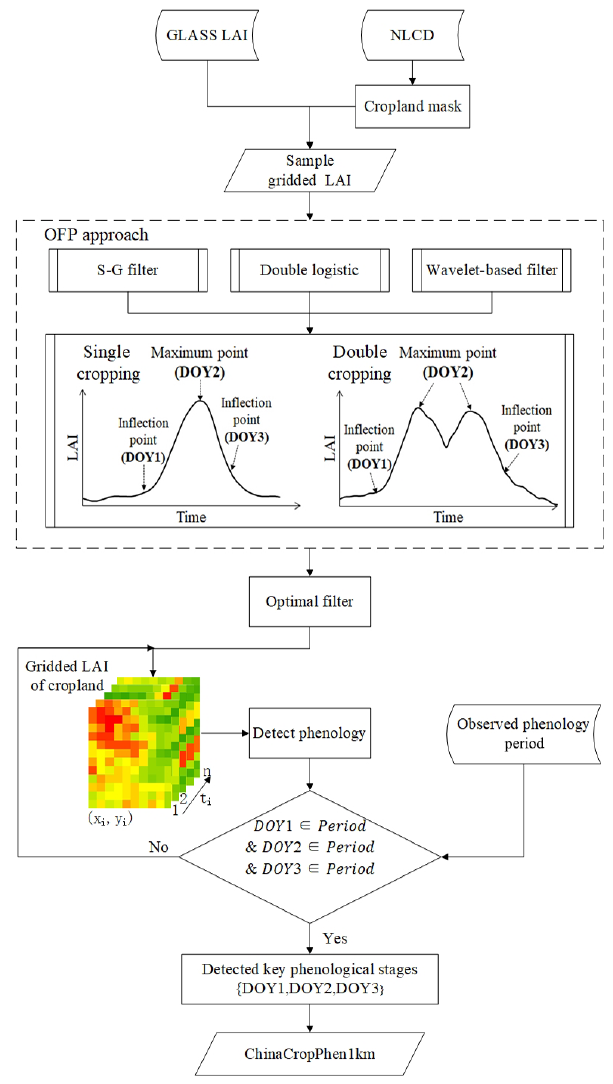
Figure 2. Flow chart of procedures for data analysis and crop phe- nological date